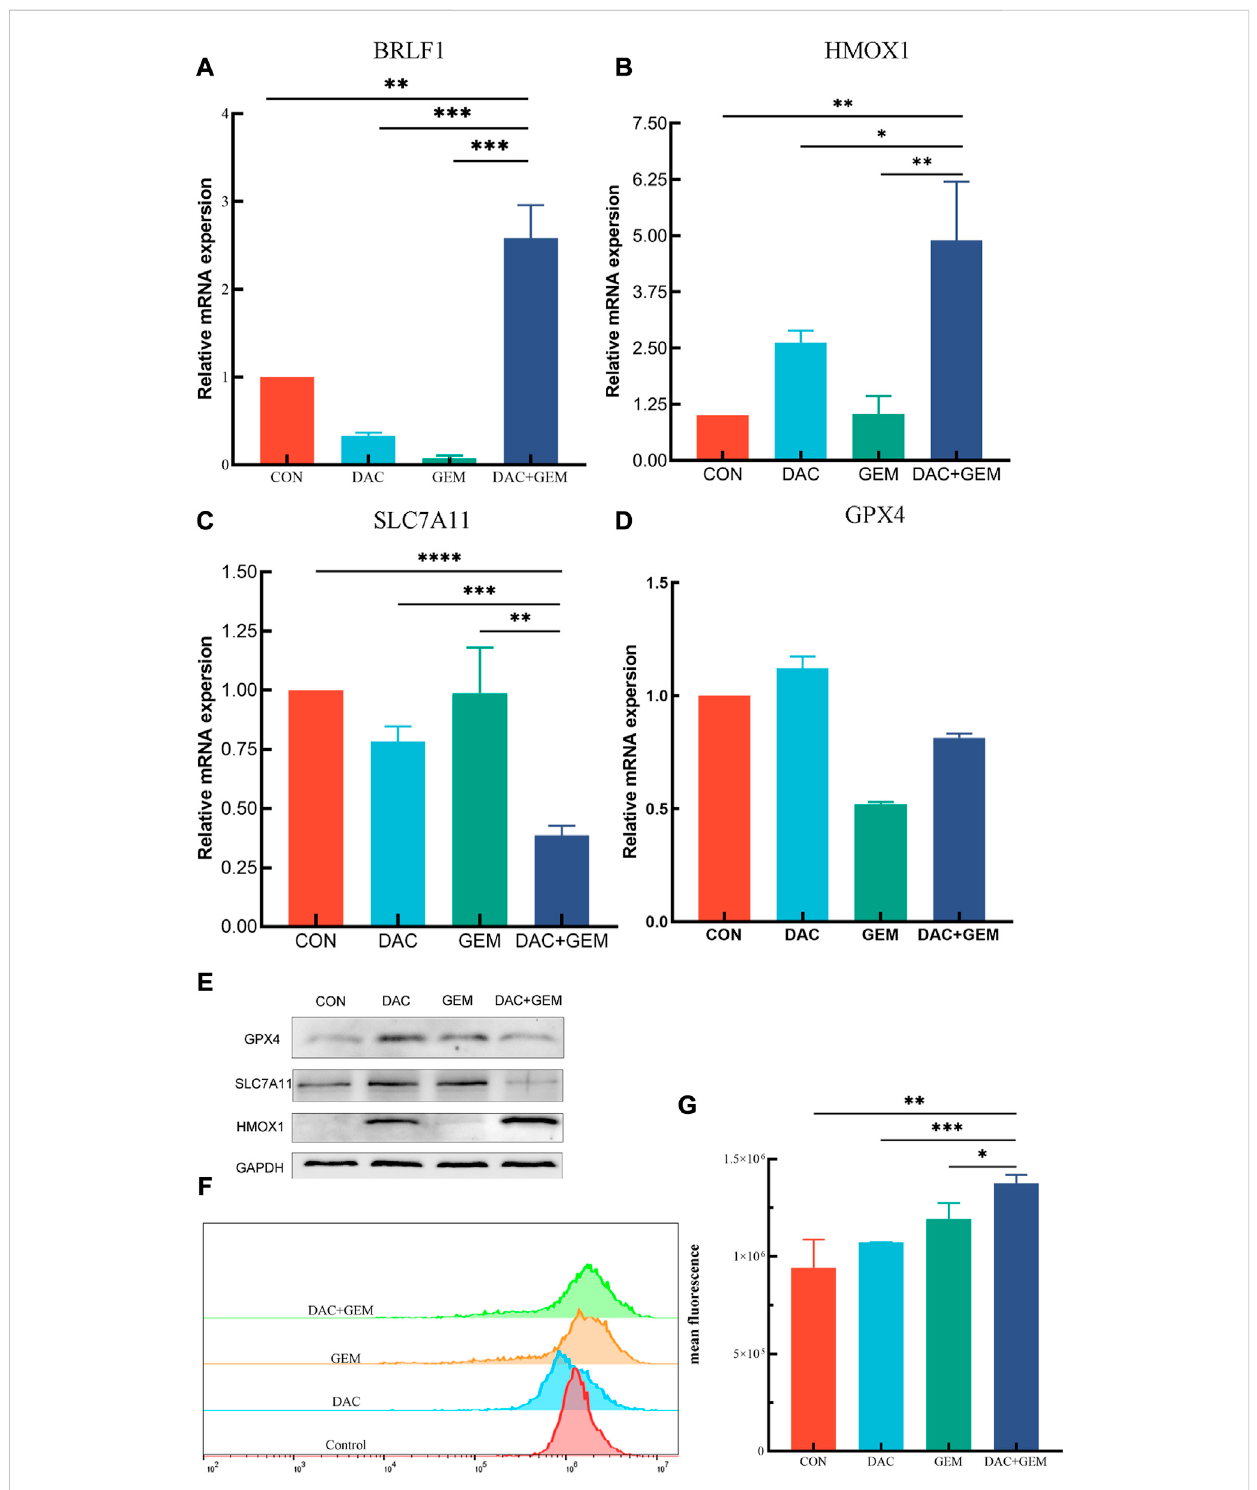
FIGURE 6 Combined treatment of DAC and GEM assists ferroptosis. (A) After treating with the indicated dose of DAC and GEM alone or in combination, BRLF1 mRNA expression was quanti fi ed by RT-PCR in NK92MI cells. (B) After treating with the indicated dose of DAC and GEM alone or in combination, HMOX1 mRNAexpressionwas quanti fi edbyRT-PCRinNK92MI cells. (C) Aftertreating with theindicateddoseofDACand GEMalone orincombination, SAL7A11 mRNA expression was quanti fi ed by RT-PCR in NK92MI cells. (D) After treating with the indicated dose of DAC and GEM alone or in combination,GPX4 mRNA expressionwasquanti fi edbyRT-PCR in NK92MI cells. (E) After treatment with theindicated dose ofDAC andGEM alone orin combination,HMOX1,SAL7A11,andGPX4proteinexpressionwereimmunoblottedinNK92MIcells. (F,G) TheeffectsofDACandGEMonregulatingROS level in NK92MI cells. * p < 0.05, ** p < 0.01, *** p < 0.001 versus control group and alone